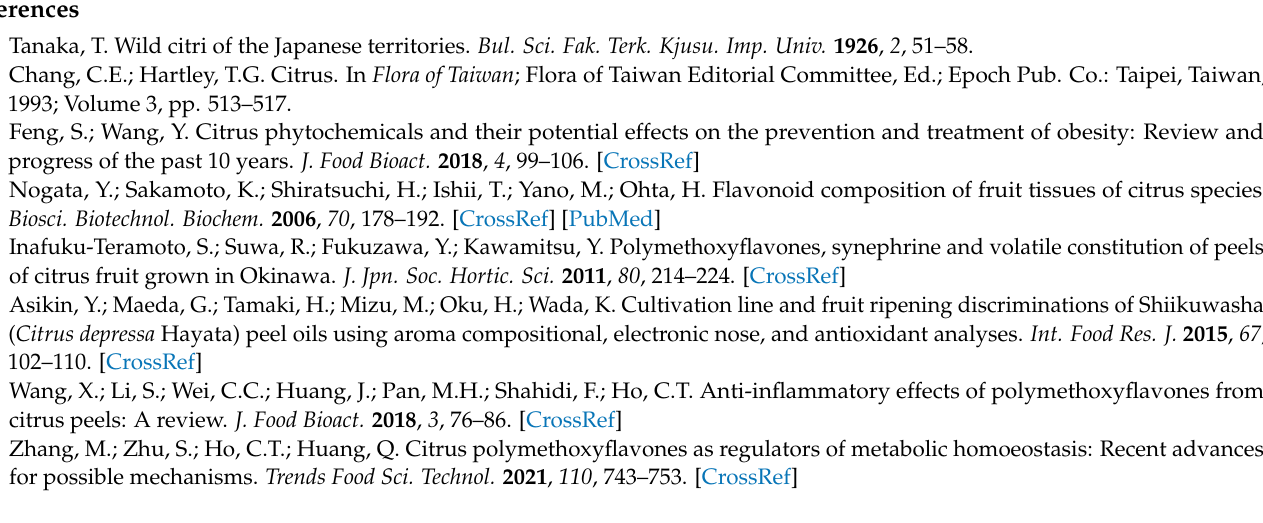
Table S4: Standardized determinant function coefficient of volatile components; Table S5: The relative gene expression of volatile